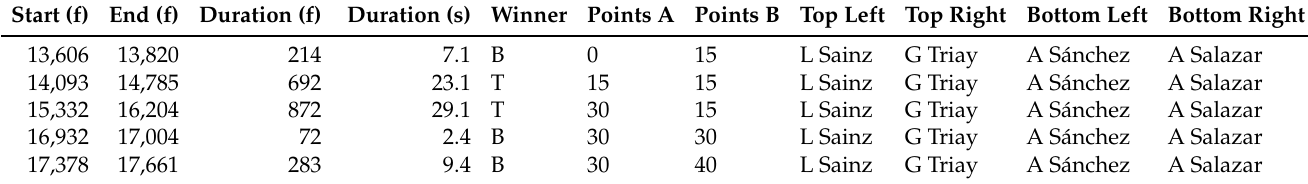
Table 1. Example of raw tabular data for padel points . The time units for the first three columns are frames. The Winner team is identified by the top/bottom position on the video.